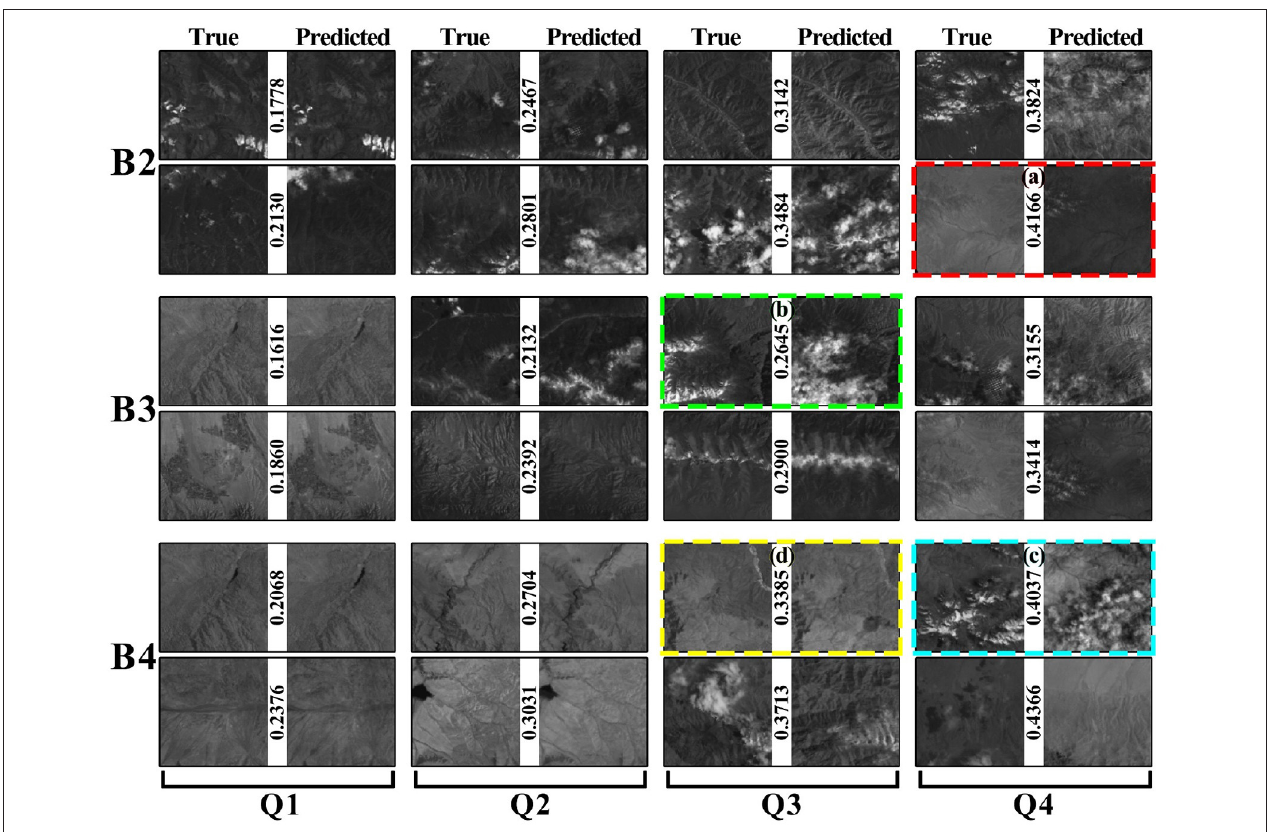
FIGURE 7 | NRMSE scores and the prediction.